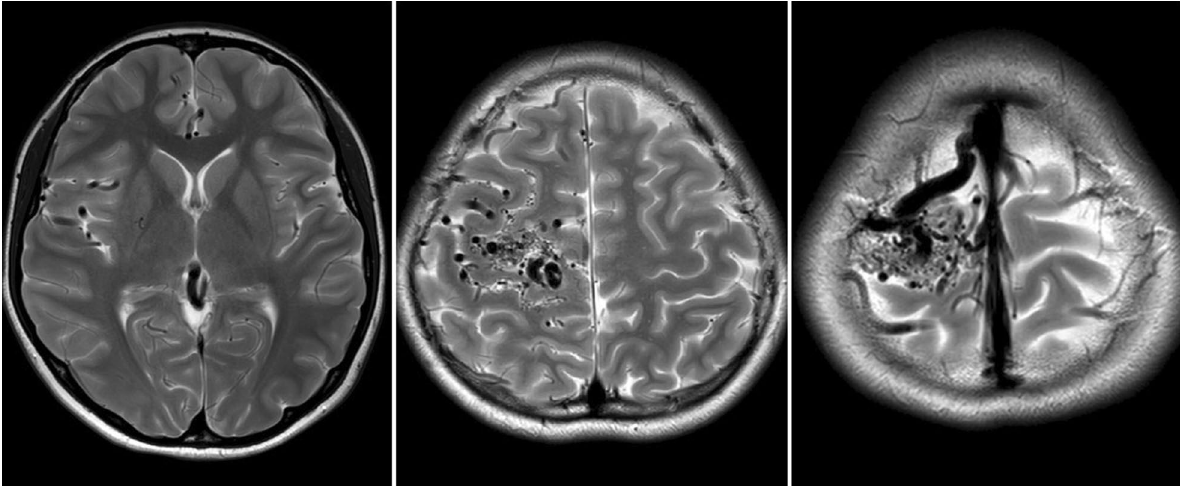
Fig. 3 Pre-operational T2-MRI with gadolinium (GD)